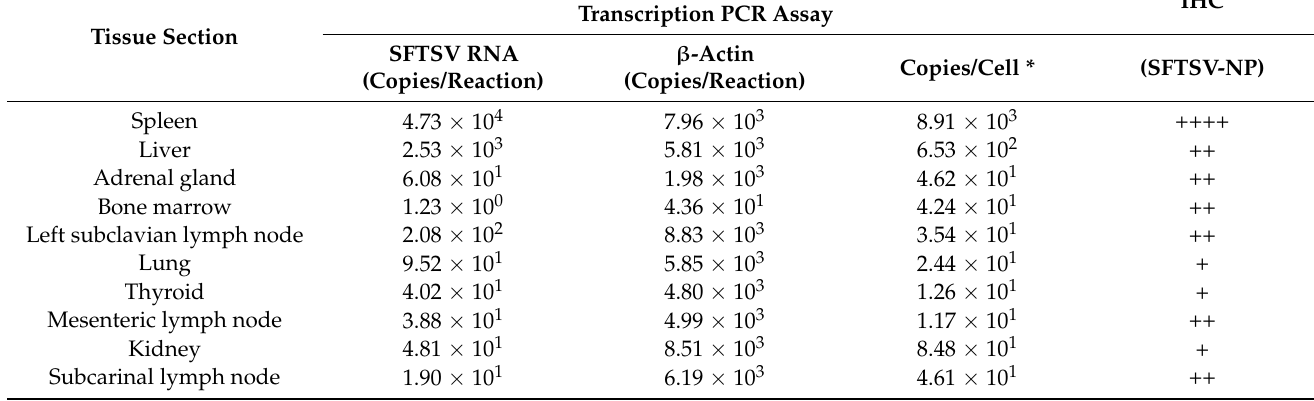
Table 3. Distribution of SFTS viral NP antigen and SFTS viral RNA in formalin-fixed and paraffin-embedded tissue sections from the autopsied